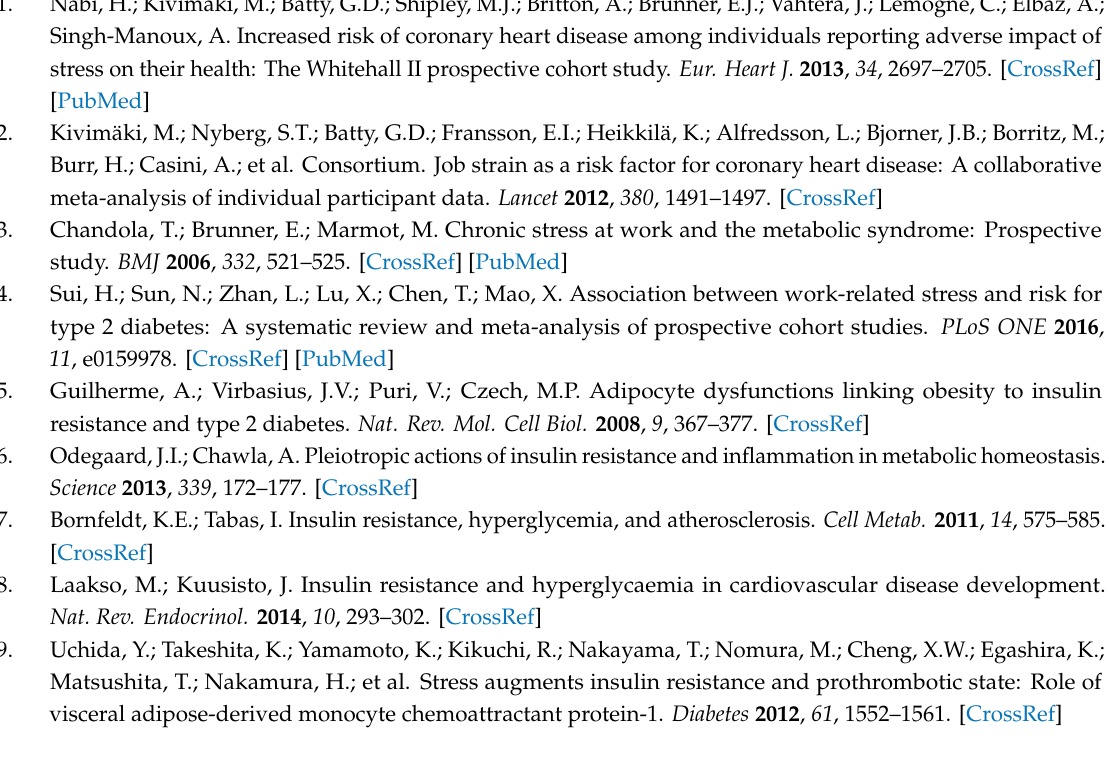
Figure S1: Apparatuses for the exposure to social stress, Figure S2: Schema of the design of the di ff erent experiments, Figure S3: E ff ects of SS on body weight, epididymal white adipose tissue (eWAT) weight, and caloric intake, Figure S4: E ff ects of SS and RSD on glucose and insulin tolerance before HFD feeding, Figure S5: E ff ects of SS on the percentage of peripheral blood monocytes after HFD feeding, Figure S6: E ff ects of SS on the fraction of eWAT macrophages, Figure S7: Quantitative RT-PCR analysis of mRNA expression levels in eWAT before and after HFD feeding, Figure S: Neutrophil elastase (NE) activation in lower limbs after HFD feeding, Figure S9: E ff ects of SS on the number of peripheral blood neutrophils, and Figure S10: E ff ects of SS on the fraction of eWAT neutrophils after